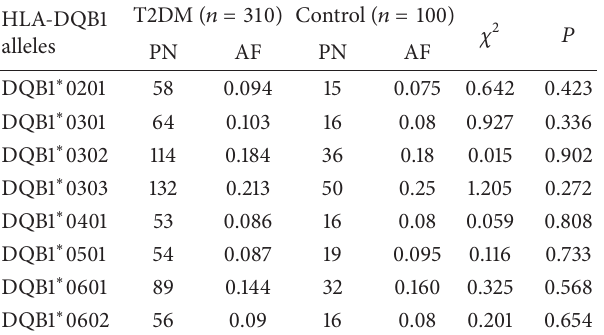
Table 6: Frequency of HLA-DQB1 alleles in T2DM patients with and without DN.